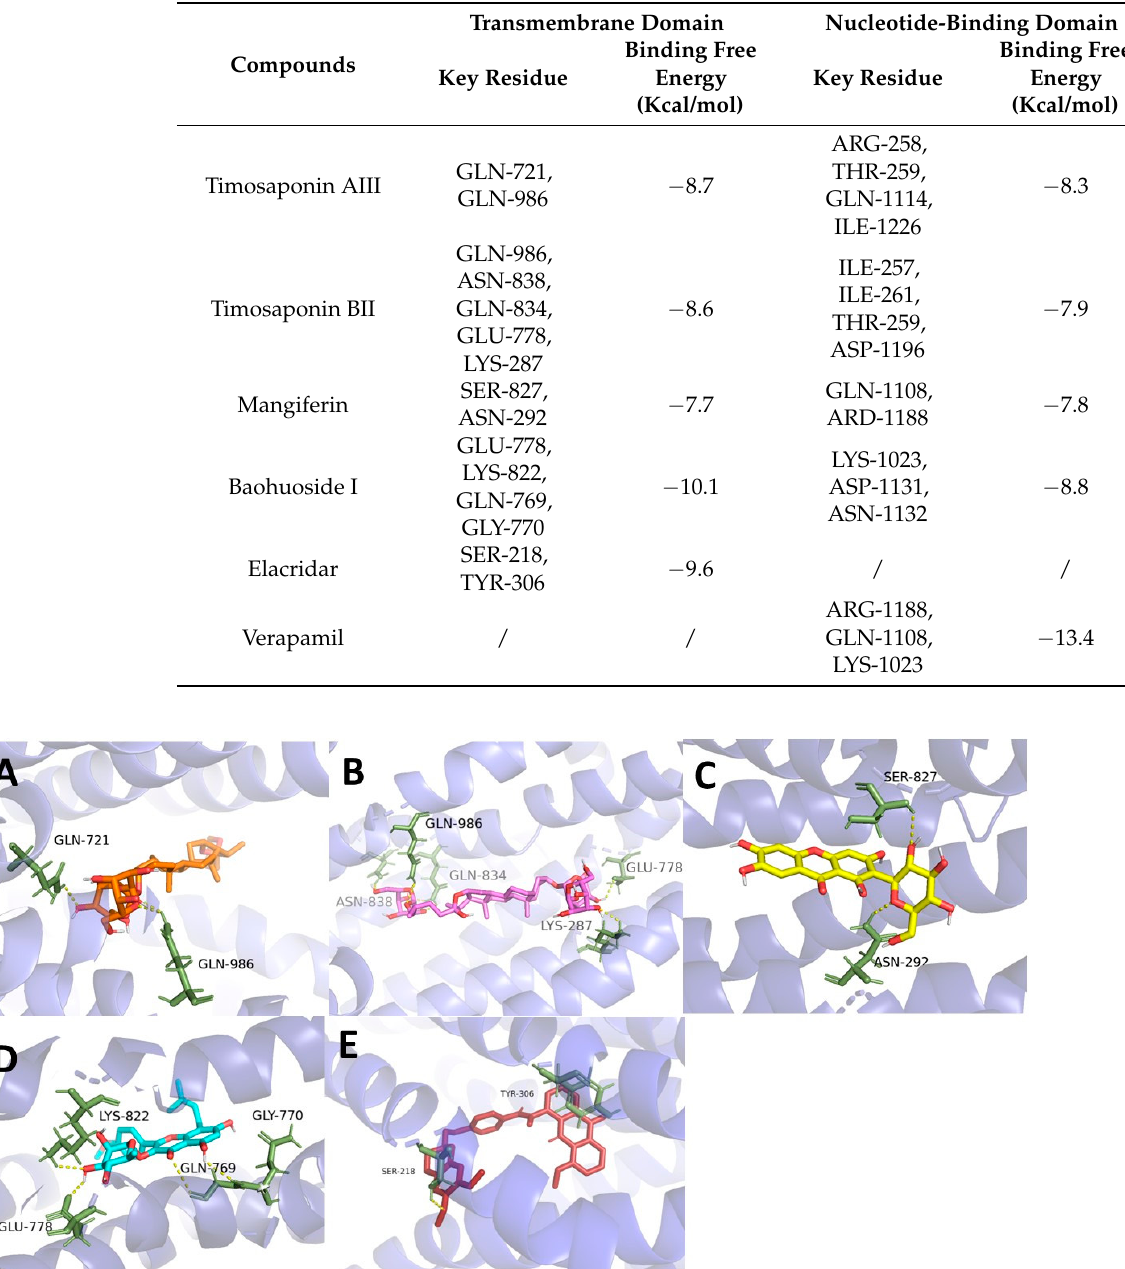
Figure 4. Binding interactions between the AR components and P-gp (Translucent purple) binding site. ( A ). TAIII (orange); ( B ). TBII (magenta); ( C ). MGF (yellow); ( D ). BHI (blue); ( E ). Elacridar (red). H-bonds, yellow dashed lines, Å.